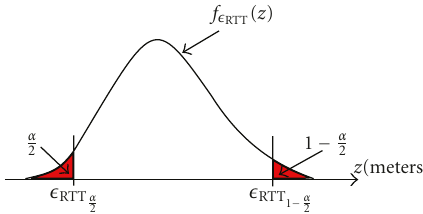
Figure 1: Graphical representation of the RTT-based constraint in a time interval ( t 1 , t N